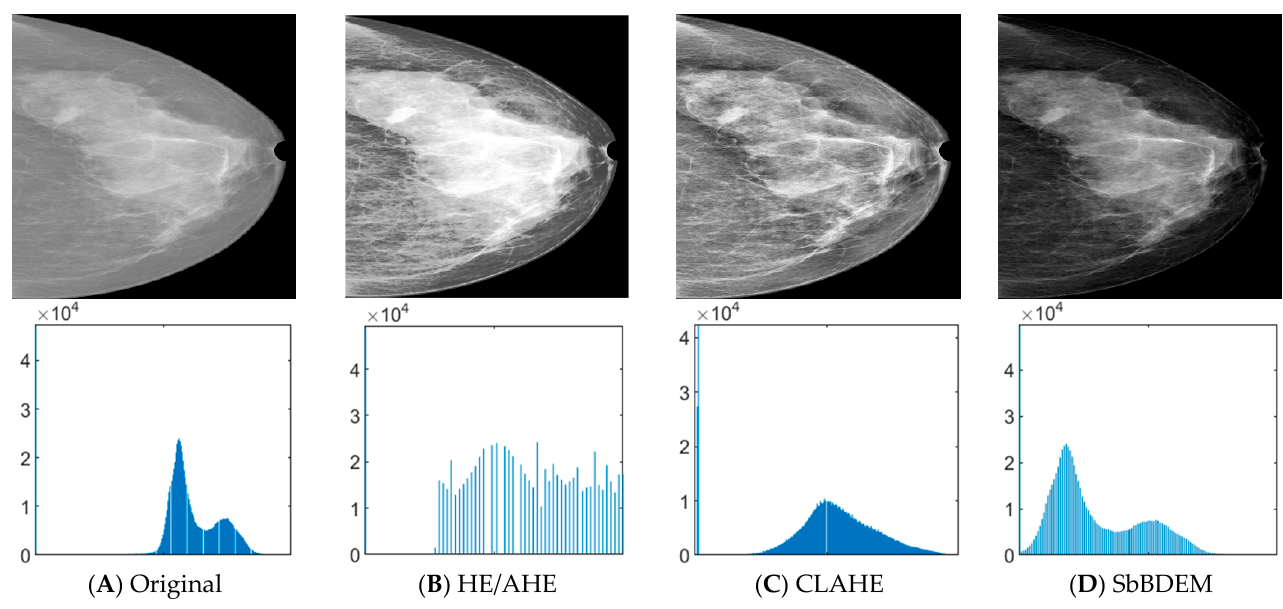
Figure 5. Sample images and histogram plots from columns of ( A ) Original, ( B ) HE/AHE, ( C ) CLAHE and ( D ) SbBDEM image enhancement techniques for comparison. Table 1. Average Quality Tests and GLCM features on INbreast Images (N = 112) using Enhancement